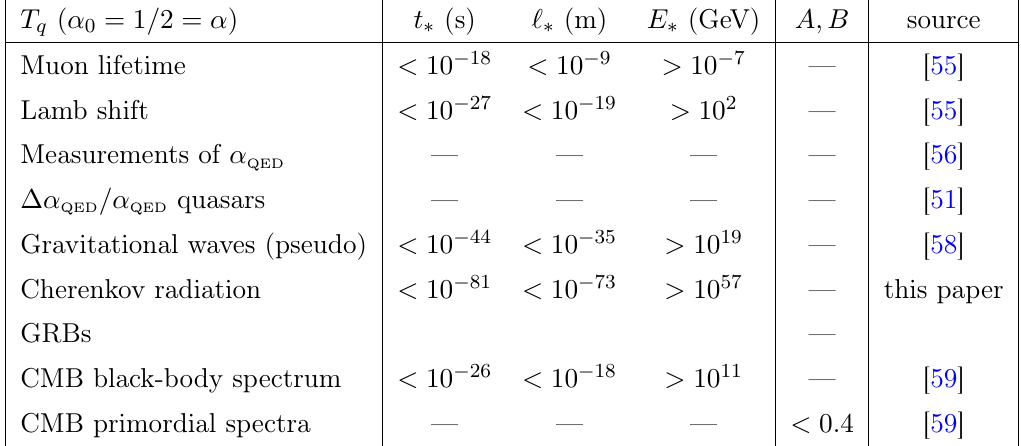
Table 7 . Bounds on the hierarchy of multifractional spacetimes with q -derivatives for (cid:11) 0 = 1 = 2 = (cid:11) . “Pseudo” indicates bounds obtainable in the stochastic view, where T q is regarded as an approxi- mation of T (cid:13) = (cid:11) .